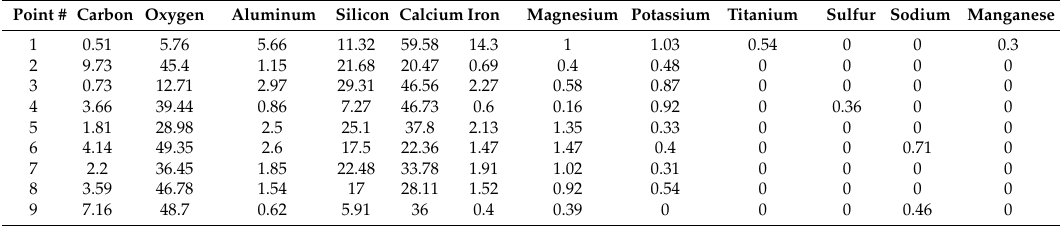
Table 5. Composition (wt %) by EDX analysis of LU ‐ I with a cutting speed of 4 m/min. Measured points are specified in Figure 14.